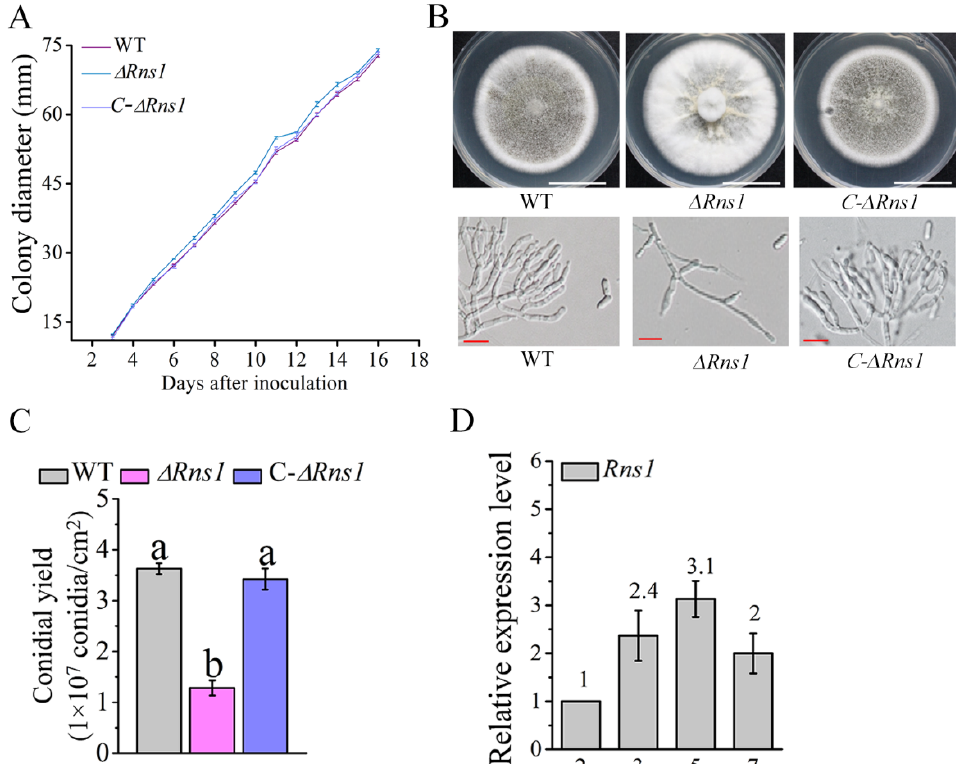
Figure 1. RNS1 regulates conidiation. ( A ) Colony growth curve on PDA plates. WT: the wild-type strain; ∆ Rns1 : the deletion mutant of Rns1 ; C- ∆ Rns1 : the complemented strain of ∆ Rns1 . Data are shown as the mean ± SE. ( B ) Colony morphology (upper panel; scale bar: 3 cm) and conidiophores (lower panel; scale bar: 10 μ m) on the PDA plates. In this study, all shown images are representative of at least three independent experiments. ( C ) Conidial yields. Conidial yield assay was repeated three times with three replicates. Data are shown as the mean ± standard error (SE). Values with different letters are significantly different ( p < 0.05, Tukey’s test in one-way ANOVA). ( D ) qRT-PCR analysis of the expression of Rns1 at the four conidiation stages of the WT strain on PDA plates. The values represent the fold-change of expression of Rns1 at a conidiation stage compared with the expression at 2 days post-inoculation, which is set to 1.